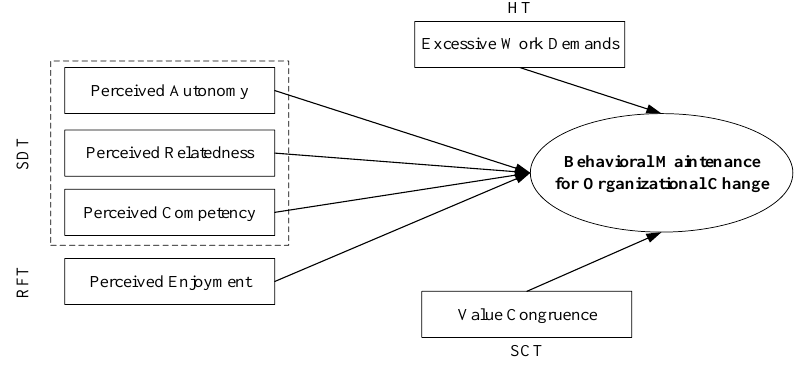
Figure 1: Framework of research